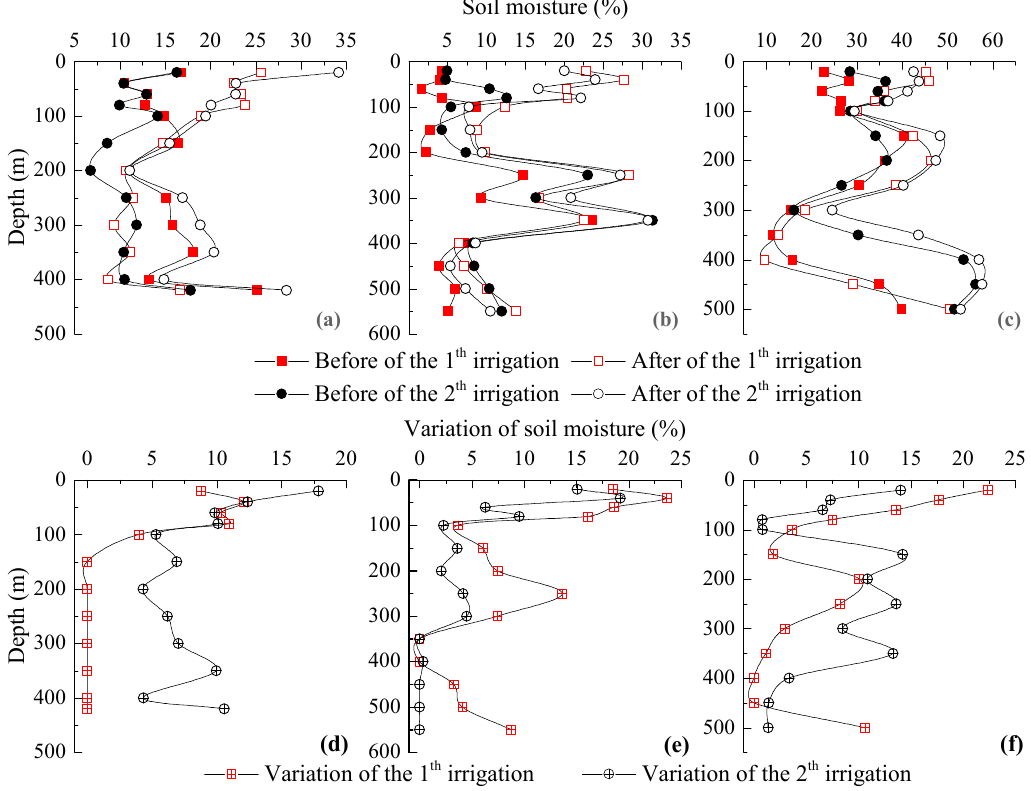
Figure 5. Vertical fluctuation curves of the soil and sediment moistures along profiles: ( a – c ) moisture fluctuation curves before and after the first and second irrigations at points 4, 9, and 17, respectively, in which the moisture measurements after the first and second irrigations in (a) were 6 and 8 h, in ( b ) were all 24 h, and in ( c ) were 18 and 24 h, respectively; ( d – f ) moisture variation curves influenced by the irrigation activities at points 4, 9, and 17, respectively.